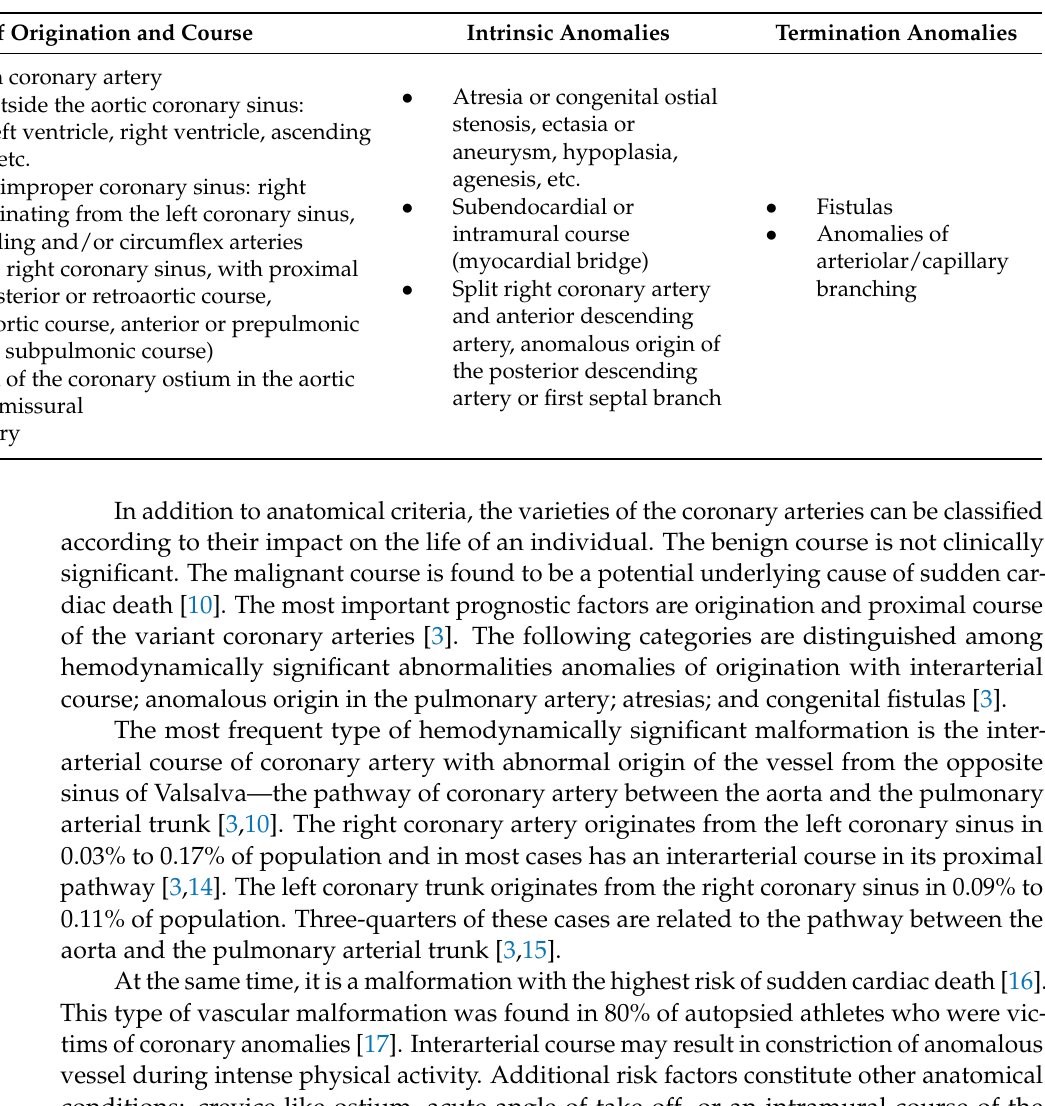
Table 1. Coronary anomalies